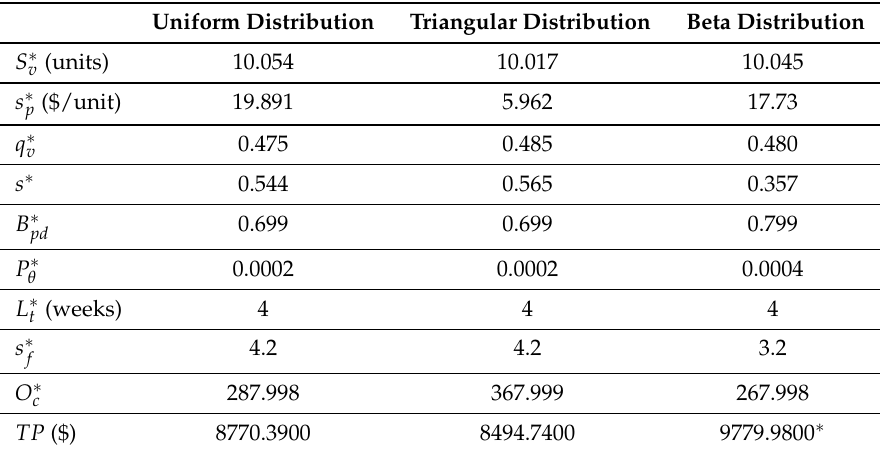
Table 6. Optimum values with service constraint.